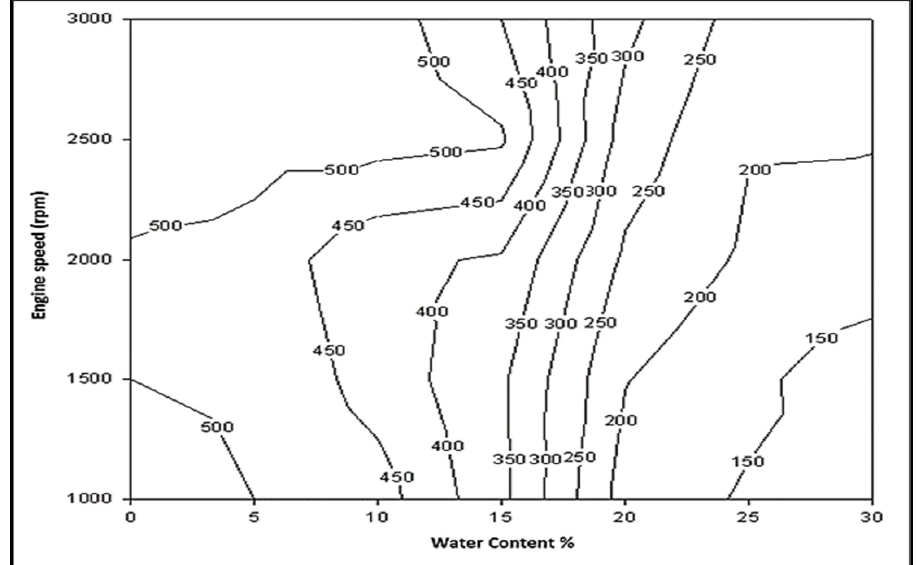
Figure 12. NOx (ppm) variation for pure diesel and different water addition to diesel fuel. Table 2. The average changes in BP, BSFC, BTE, and NOx for CI engines driven by various percentages of W/D emulsion fuel against pure diesel fuel.